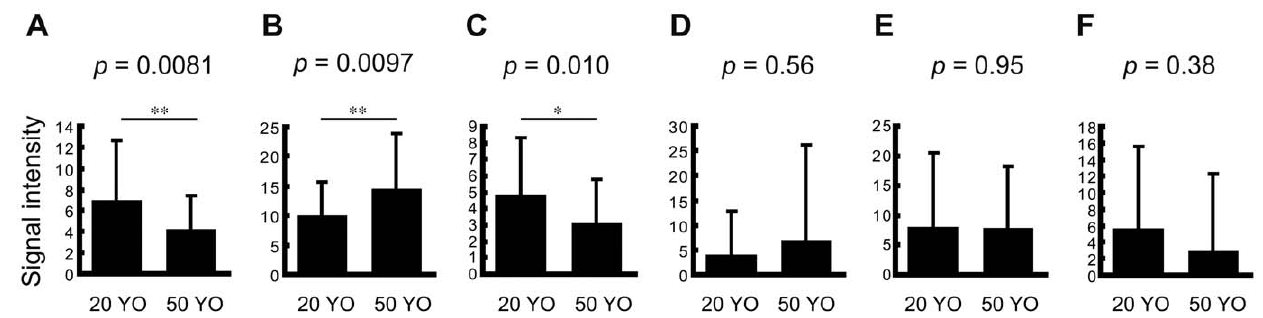
Figure 4. Putative aging marker intensity in the cortex and medulla. (A–C) Mean signal intensity in the hair cortex in the 20 YO and 50 YO groups is displayed. (D–F) Mean signal intensity in the hair medulla in the 20 YO and 50 YO groups is displayed. (A, D) m/z 153.00. (B, E) m/z 164.00. (C, F) m/z 207.04. All values are shown as mean 6 standard deviation *: p , 0.05.